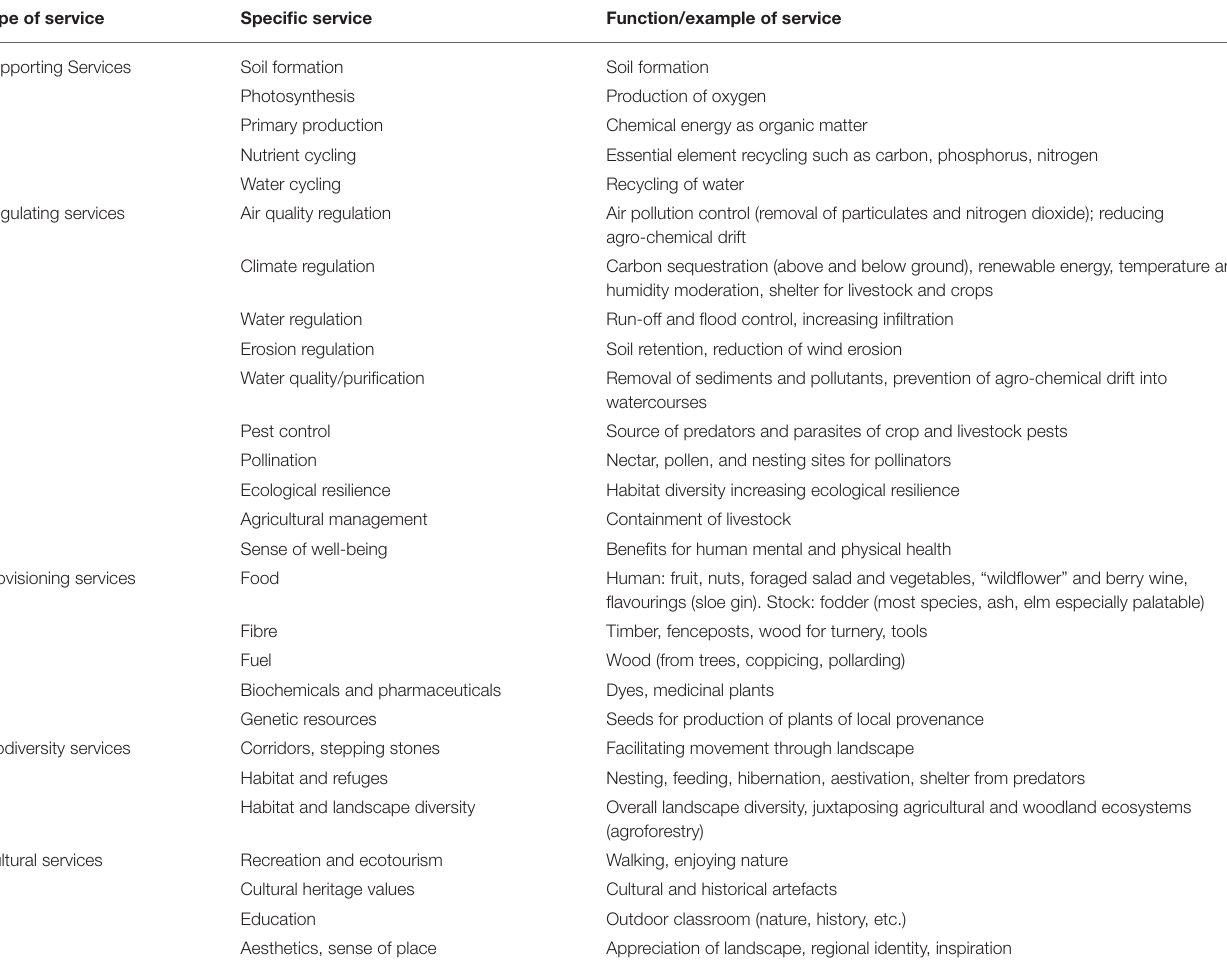
TABLE 1 | Ecosystem services delivered by hedgerows (adapted from Dover,